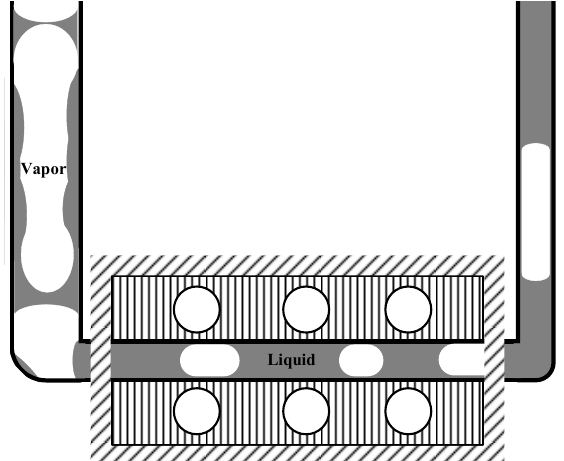
Figure 11. Dual diameter on the fluid distribution of PHP.